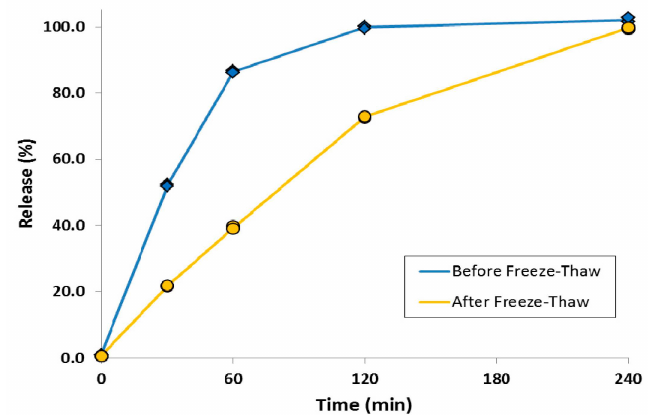
Figure 18. The effect of freeze-thaw process on the in vitro release profiles of ciprofloxacin from Lipoquin. Duplicate samples were analyzed at each time point. The IVR assay is described in [43]. Reprinted with permission from [80].